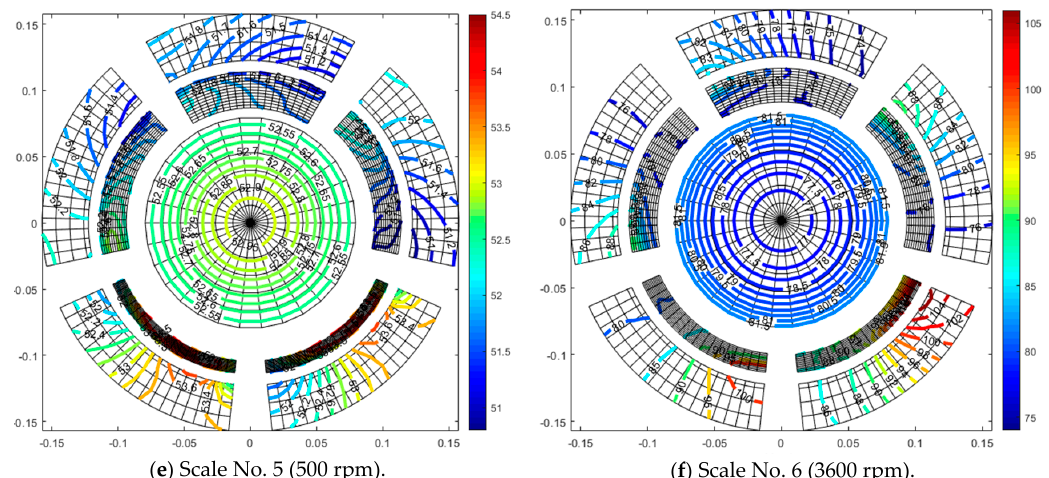
Figure 8. Thermal gradient of tilting pad journal bearing system.